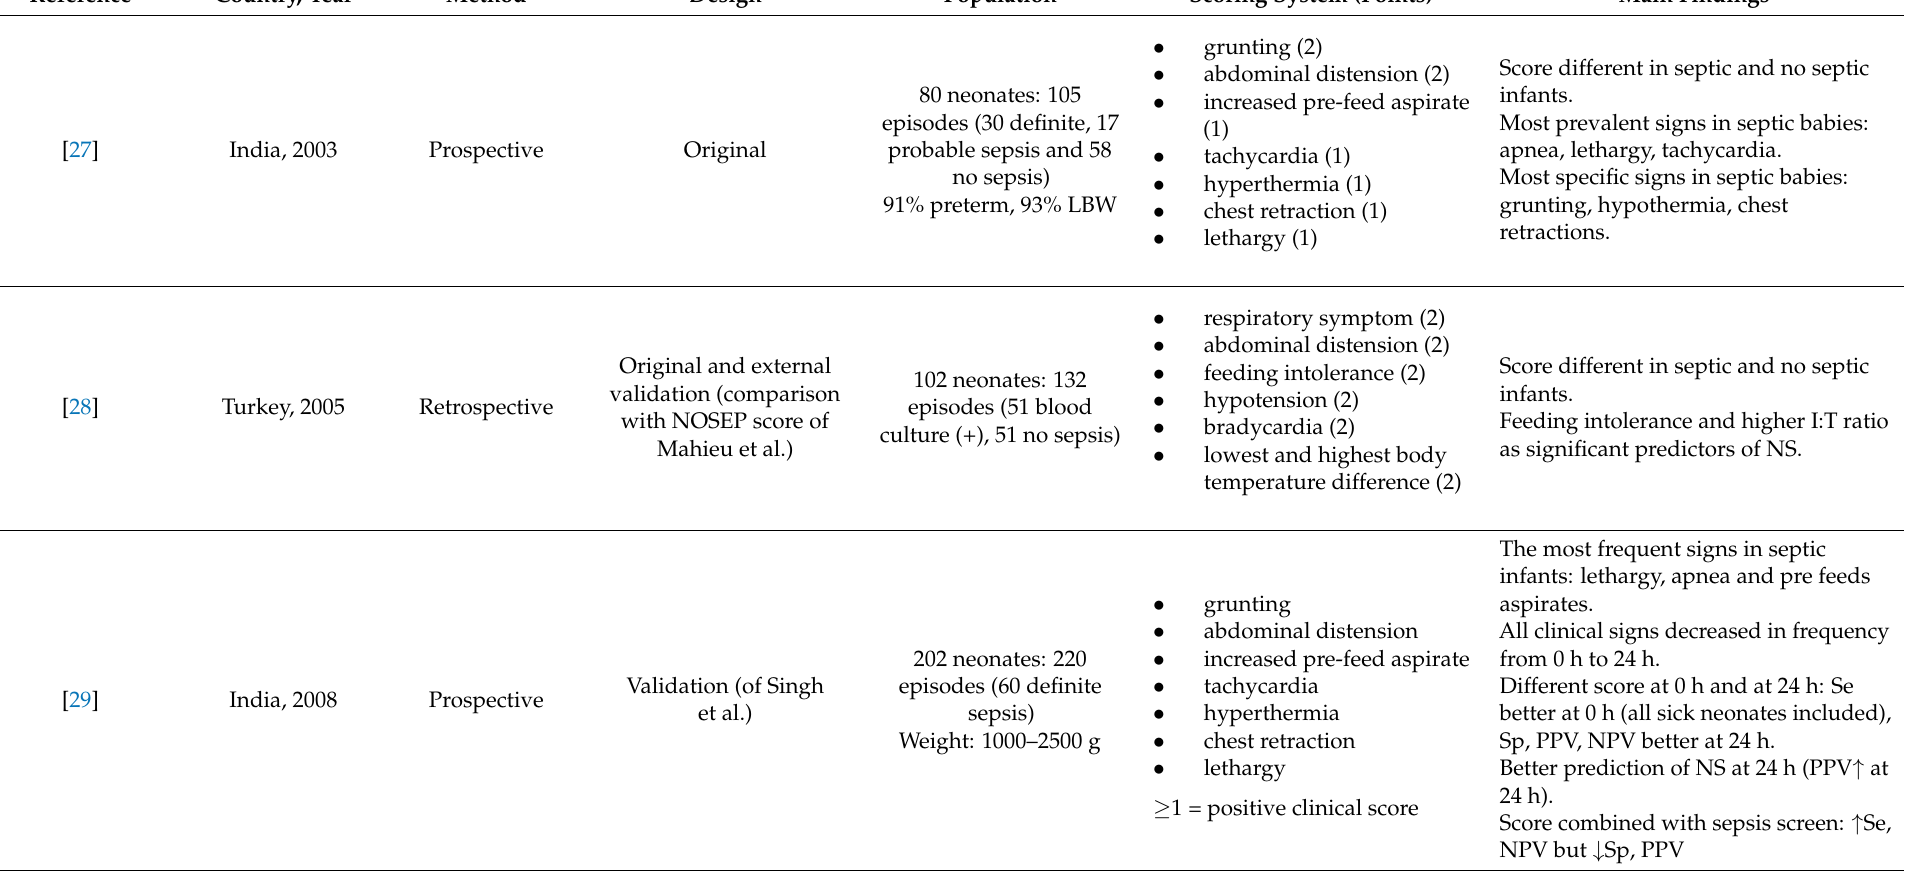
Table 1. Predictive scores for the LOS with clinical